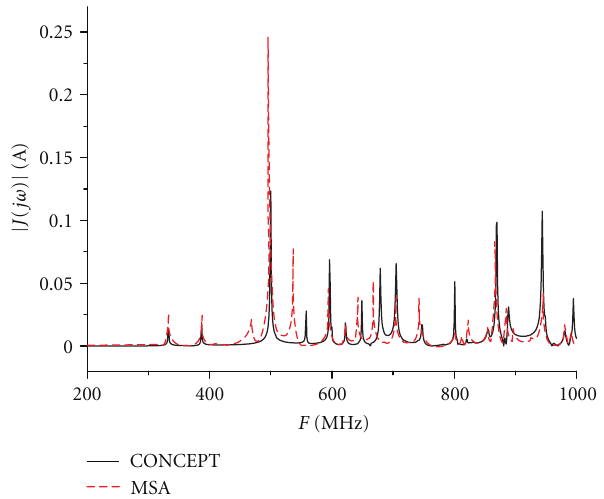
Figure 6: Comparison of results of MSA with